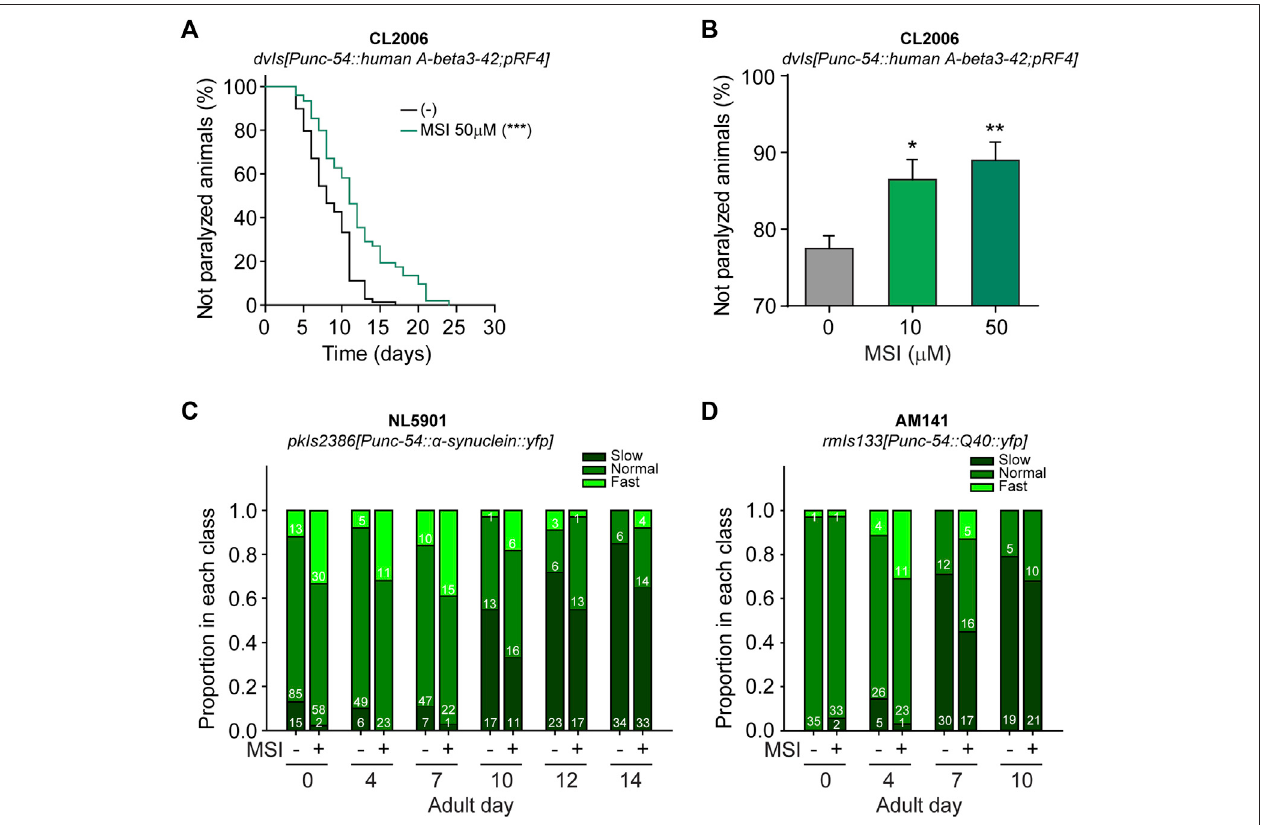
FIGURE 3 | Evaluation of MSI impact on proteotoxic-associated phenotypes in C. elegans models of NDs. (A) . In fl uence of MSI on the paralysis of animals expressing human β -amyloid 3 – 42 in muscles throughout its lifetime. Data show a representative Kaplan-Meier curve in the absence and presence of 50 μ M MSI. Statisticaldifferenceswereevaluatedbyalog-ranktest(*** p < 0.001). (B) .Evaluationofparalysisafteraheatshock(35 ° Cfor30 min).Datainthebargraphrepresentthe mean ± SEM from 4 independent experiments with 50 – 80 animals per condition per experiment. Statistical signi fi cance was evaluated by One-way ANOVA followed by Holm – Sidak ’ s test for multiple comparisons against the control group (0 μ M MSI) (* p < 0.05, ** p < 0.01). (C,D) . Swimming behavior evaluated in C. elegans strainsexpressing α -synuclein (C) and poly-Q repeats (D) in theirbody wallmuscles.Datawereclassi fi edintothree speedcategoriesbasedonthrashingratesofyoung adultanimals:normalincludesthoseanimalsmovingataspeedbetween25%and75%oftheaveragethrashingrateatday0,slowaccountsforthoseanimalsmovingat aspeed lowerthan 25%ofaveragethrashingrateofday 0adults,and fastcomprises thoseanimals movingat ahigher speed than75%ofcontrol. Numbersinsidebars show the number of animals falling in each category.